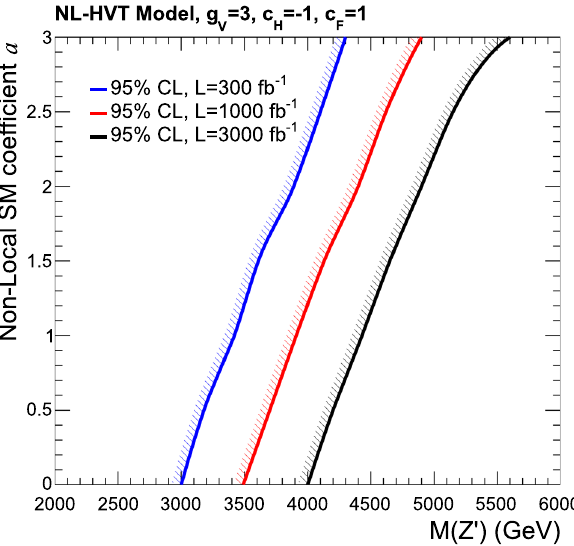
Fig. 8 95% Confidence Level limits in non-locality scale Λ NL as a function of the parameter a and the integrated luminosity, based on measurements of anomalous Higgs production from a Z (cid:2) resonance.